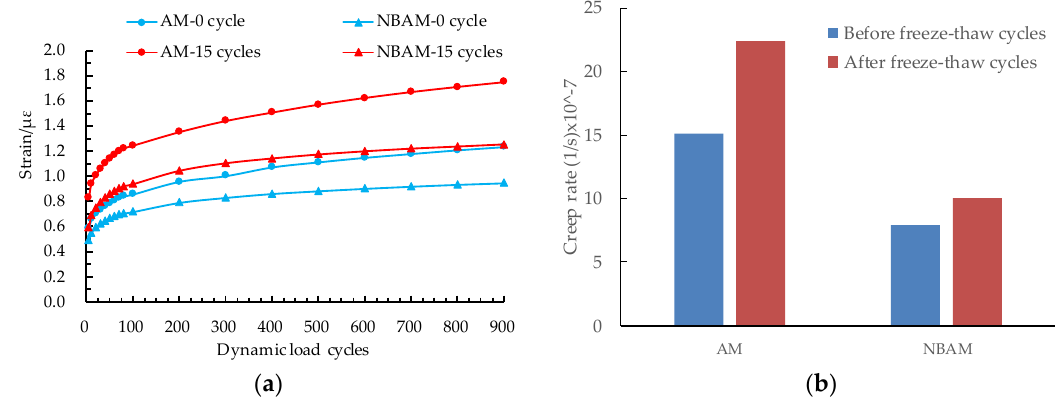
Figure 12. Dynamic creep: ( a ) relationship between dynamic creep time and strain; ( b ) the change of creep rate.